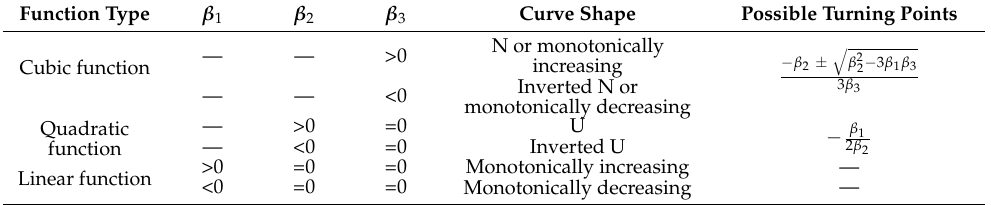
Table 1. Possible results of the cultivated land pressure Kuznets curve